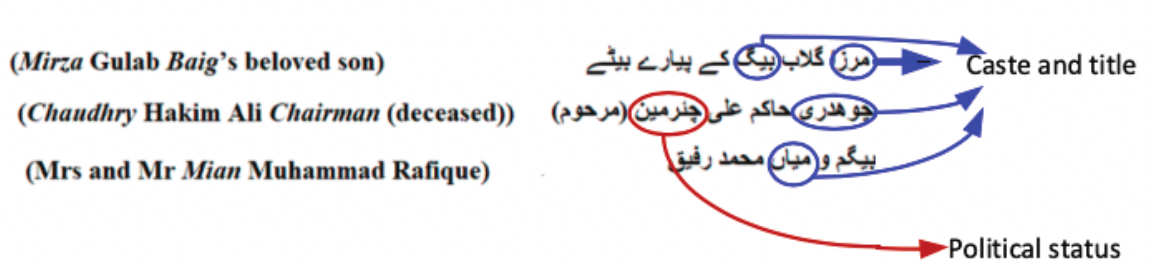
Figure 3: Identifying celebrating family and naming convention